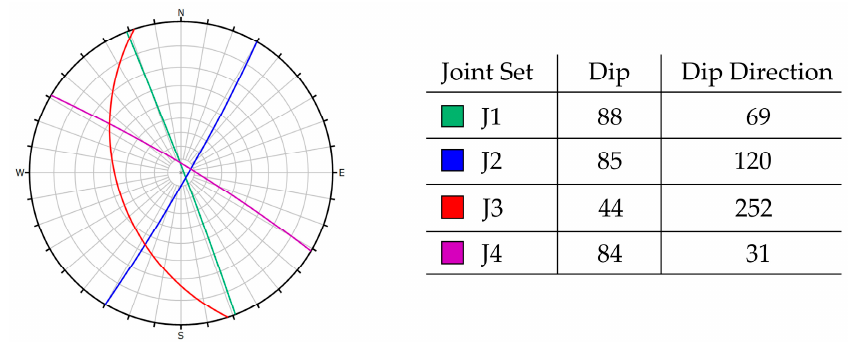
Figure 3. Overview of the five lithological units of the CN Ashcroft Mile 109.4, depicted in a photogrammetry point cloud, high-resolution photographs, and a mapped bedrock model. The photogrammetry point cloud was generated from a series of photographs taken from a helicopter. Further information involving the construction of the photogrammetry dataset and subsequent geological mapping is presented in Sections 2.1.3 and 2.2.7, respectively.